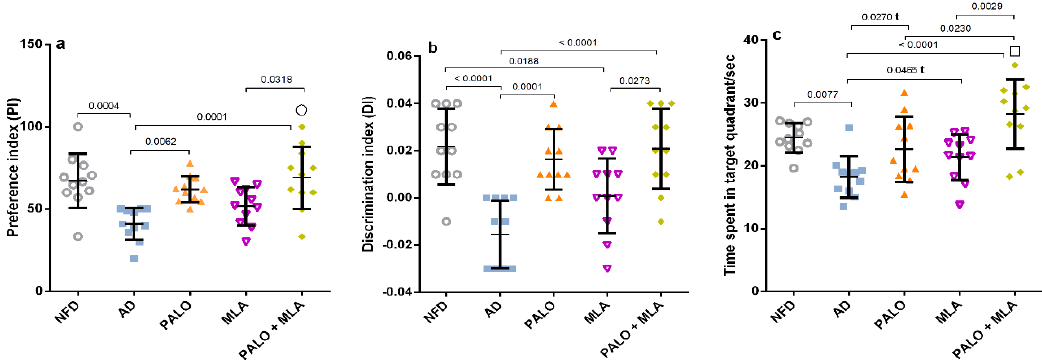
Figure 4. Effect of PALO and/or MLA on ( a ) PI and ( b ) DI during NOR test and ( c ) time spent in the target quadrant during MWM test in HFFD/LPS-induced AD model. Values are shown in scatter plots and expressed as mean ± SD ( n = 11/group). Statistical analysis was performed using one-way ANOVA followed by Tukey ’ s post hoc test; (t) denotes significance using unpaired Student ’ s t-test between 2 groups; p < 0.05. The symbols (□) and ( ○ ) indicate additive and synergistic interactions, respectively, using coefficient drug index (CDI). PALO (0.1 mg·kg −1 ; i.p) and/or MLA (5.6 mg·kg −1 ; i.p) were administered 3 h after LPS injection and for 8 days. Training for MWM (day 4 – 7) was followed by probe test (on day 8). The NOR test habituation and familiarization phases (days 6 and 7) were followed by the probe test (day 8). MWM: Morris water maze.